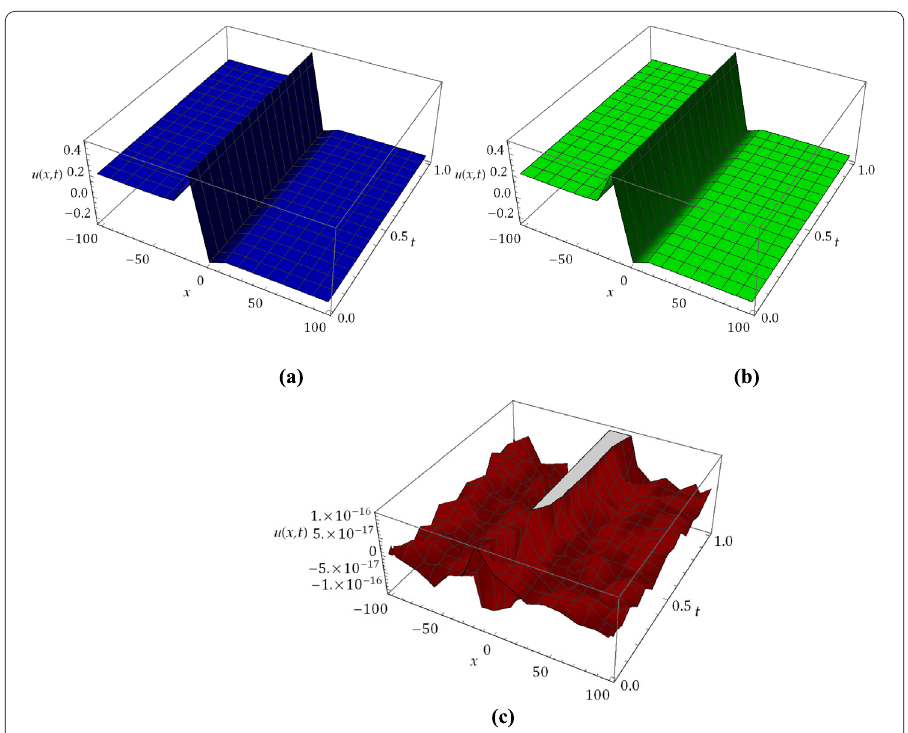
Figure 1 Behaviour of ( a ) Approximate solution ( b ) Exact solution ( c ) Absolute error = | u exa . – u app . | for Example 6.1 at ω = 0.005, (cid:13) = 0.1, c = 10, n = 1, α = 1 and (cid:2) =